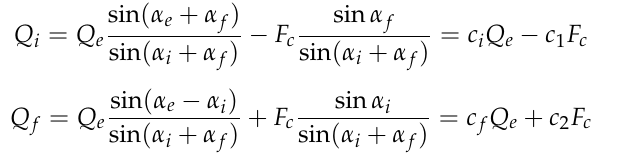
Figure 2. Stress analysis of roller.